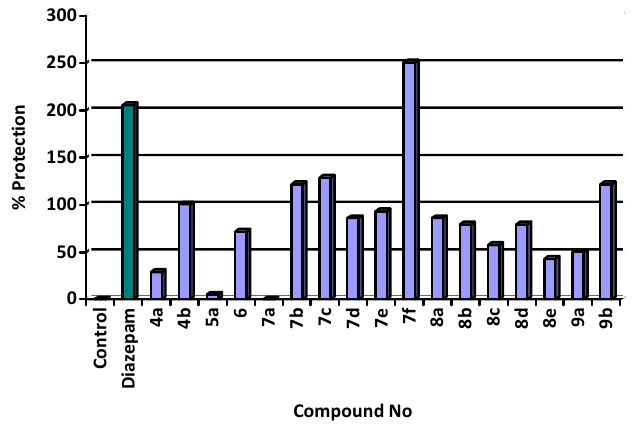
Figure 2. Graphical representation of the anticonvulsant activity of the quinazolin-4(3 H )- ones compared to